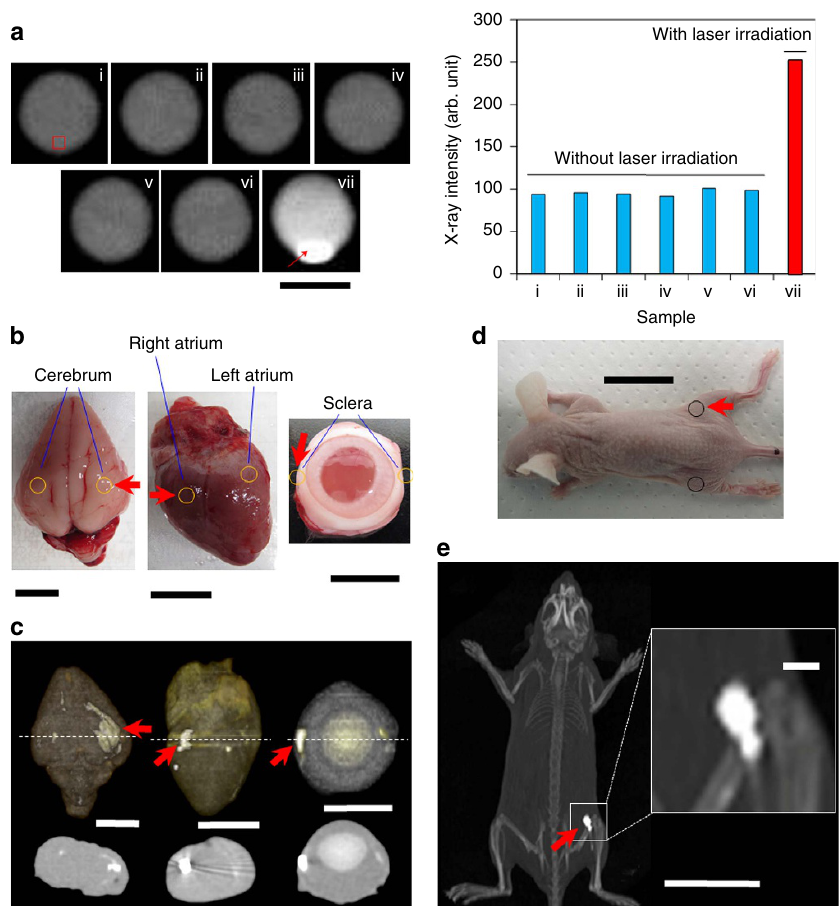
Figure 6 | Targeting X-ray-enhanced imaging by laser-induced transformation of LM nanocapsules. ( a ) X-ray imaging and analysed intensity of LM nanocapsule solution in vials at various concentration (i: 0mgml (cid:2) 1 ; ii: 0.01mgml (cid:2) 1 ; iii: 0.1mgml (cid:2) 1 ; iv: 0.25mgml (cid:2) 1 ; v- 0.5mgml (cid:2) 1 ; vi: 1mgml (cid:2) 1 ; and vii: 1mgml (cid:2) 1 ). Only sample vii was irradiated by 785nm laser at 1W ( B 80mWmm (cid:2) 2 ) for 1h. The red square indicates the location at which the X-ray intensity was analysed in images. The red arrow represents the precipitation that formed by laser-driven transformation of LM nanocapsules. Scale bar, 1cm. ( b ) Photos of LM nanocapsules-injected rabbit organs (left: brain, centre: heart, and right: eye ball). Orange circles show injection parts of LM nanocapsules. Red arrows show the laser-irradiated sites. Scale bars, 1cm. ( c ) 3D-X-ray images and sectional views of rabbit heart, brain and eye ball injected with LM nanocapsules. Red arrows display the laser-irradiated sites. Dashed lines represent location for cross-section views. Scale bars, 1cm. ( d ) Image of LM nanocapsules-injected mouse. Black circles show injection parts of LM nanocapsules. Red arrow shows the laser-irradiated site. Scale bar, 3cm. ( e ) 3D-X-ray image of LM nanocapsules-injected living mouse. Red arrow display the laser-irradiated site. Inlet image shows the magnified view of laser-irradiated part. Scale bar, 3cm (Inlet: 2mm). 3D,